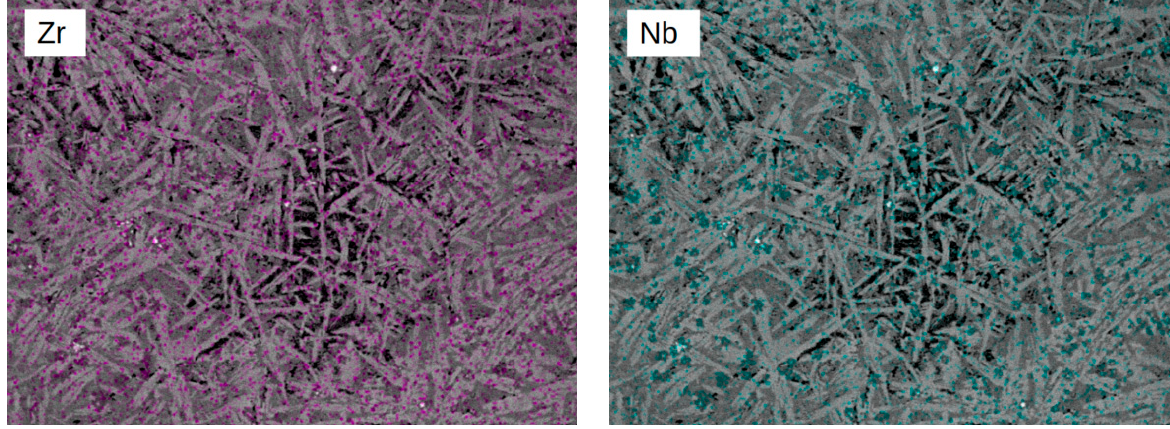
Figure 3. Maps of the selected elements for the [(Fe 80 Nb 6 B 14 ) 0.88 Dy 0.12 ] 0.95 Zr 0.05 alloy determined using the EDX technique.